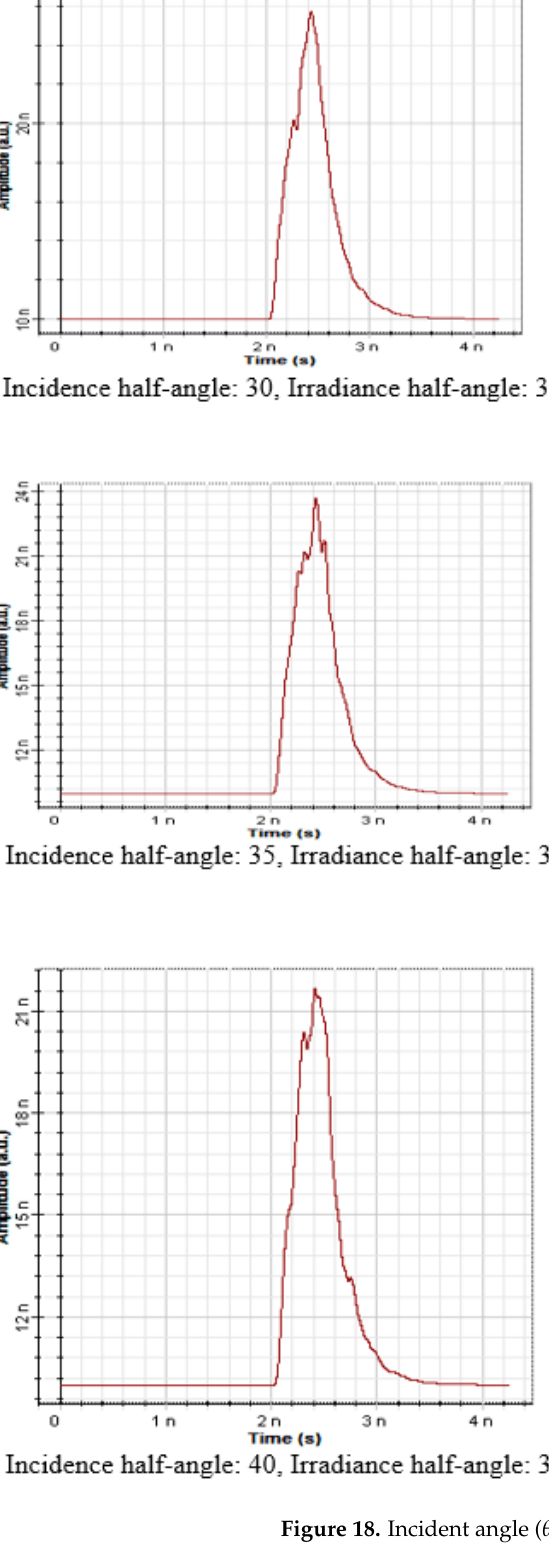
Figure 18. Incident angle ( θ d ) effect on the LOS propagation model ( θ d changes from 30 ◦ to 50 ◦ ). Figure 19 summarises the irradiance and incident angle effect on the receiver signal amplitude. It can be seen that with the angle values from 0 ◦ to 15 ◦ , the signal amplitude fluctuates with higher and lower values. When the angle reaches 20 ◦ or higher values, the signal distortion is directly proportional to the angle values. The signal